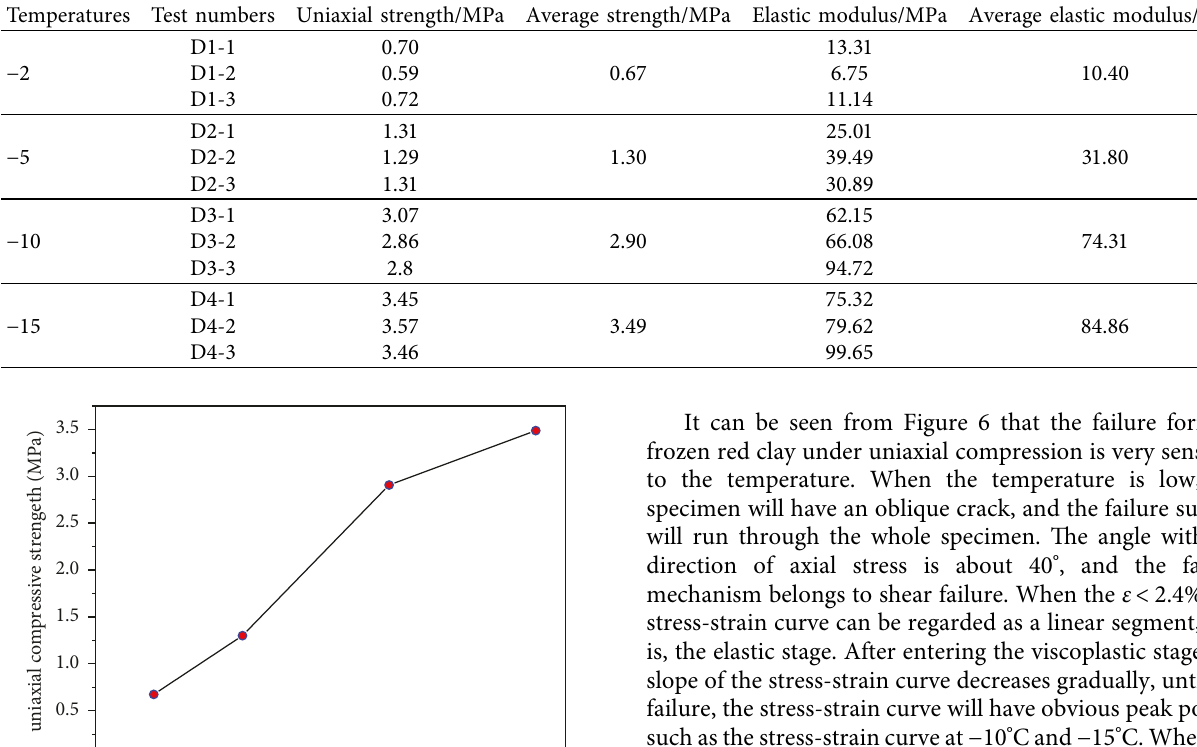
Table 2: Uniaxial compressive strength and elastic modulus at different temperatures.